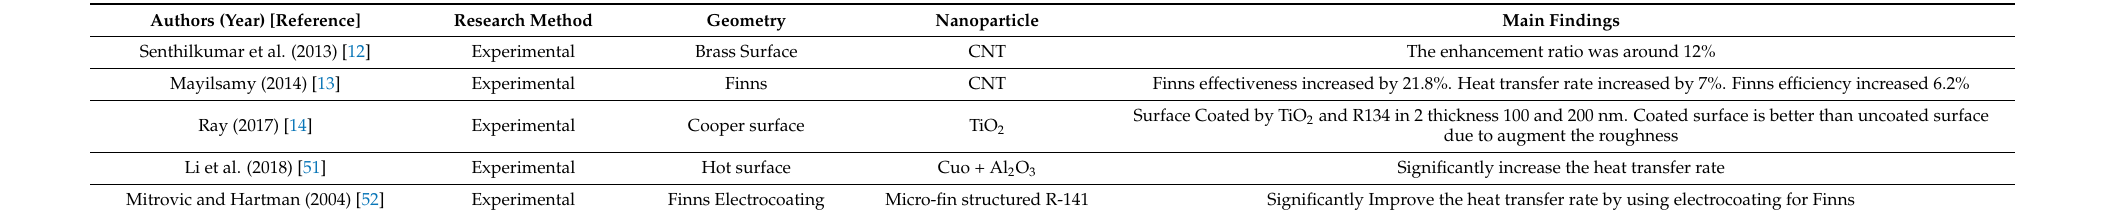
Table 7. Comparison of nanocoating application